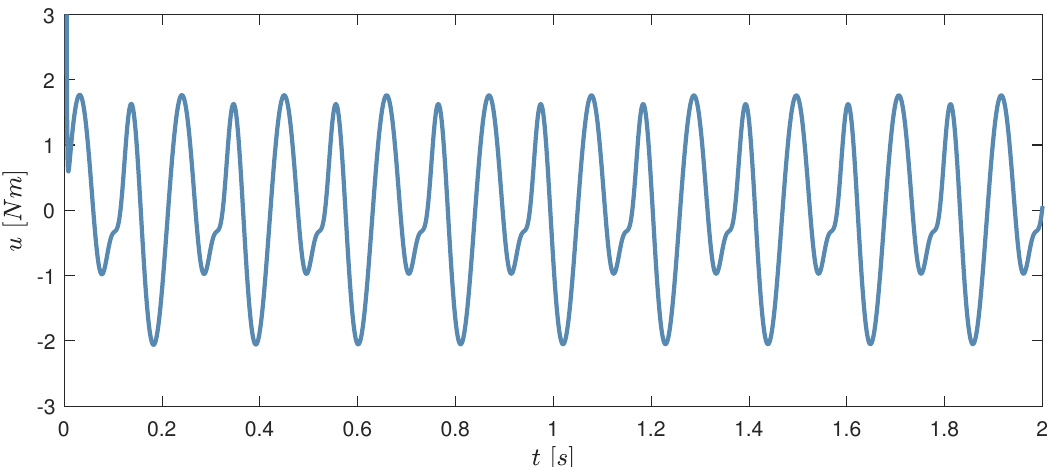
Figure 14. Computed dynamic model for the optimal solution for the case in Figure 7 in terms of angular velocity.